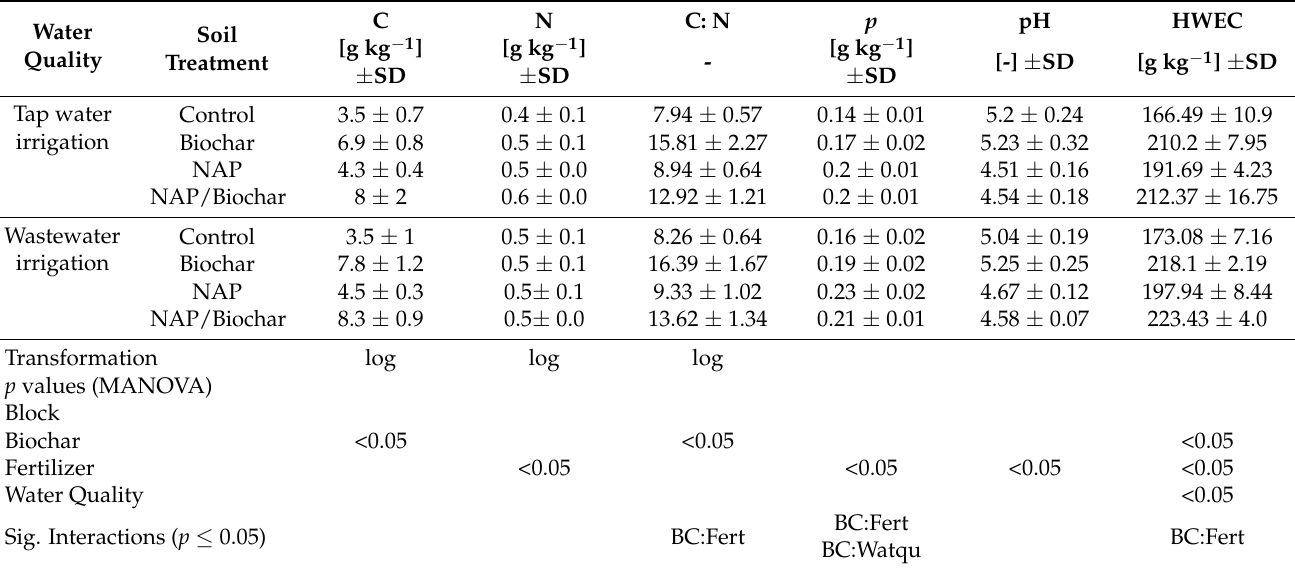
Table 2. Chemical properties of soil under two different irrigation water treatments, statistically significant effects and interactions are indicated by p -values ( p < 0.05) of MANOVA. Means ± one standard deviation, n = 4. Transformation applied after Shapiro Wilk test are indicated for each parameter. BC, Fert and Watqu in the table represent biochar, fertilizer and water quality